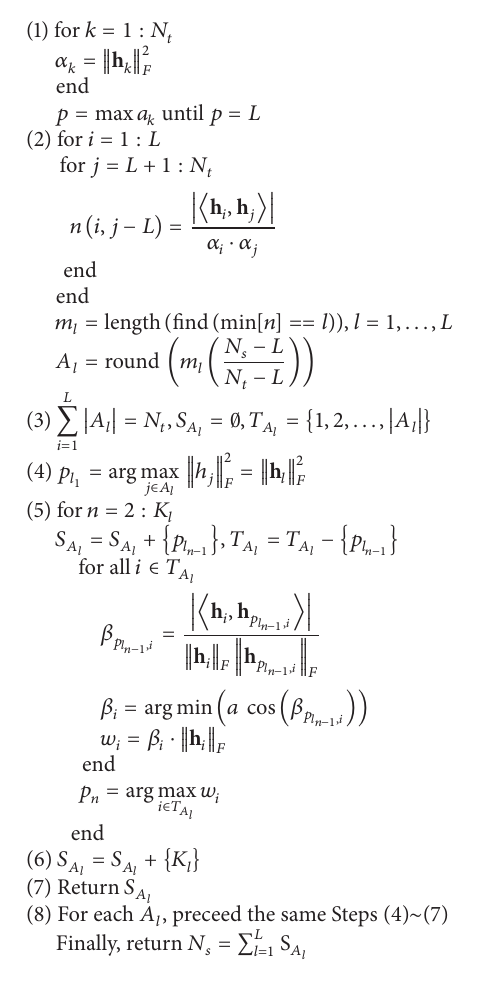
Algorithm 1: The procedure of NAG-SD TAS scheme.